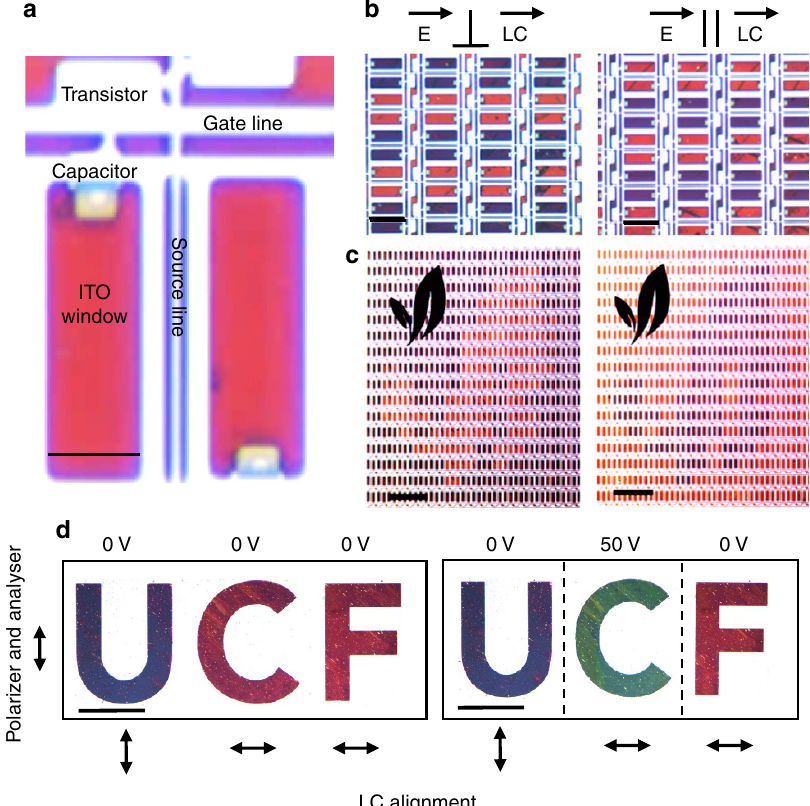
Figure 6 | Passive and active addressing. ( a ) A microscope image taken with a (cid:4) 10 objective of the plasmonic surface integrated with a thin-film- transistor (TFT) array. Pixels can be controlled through a computer interface and ( b ) shows when every third and fourth row are turned on for the parallel and perpendicular incident light cases with respect to the top LC alignment layer. ( c ) Arbitrary images displayed from the device taken with a (cid:4) 4 microscope objective. ( d ) A passively addressed device with UV lithographically patterned ‘UCF’ as a function of applied field, polarizer and analyser alignment and LC photoalignment director. Scale bars, ( a ) 30 m m, ( b ) 80 m m, ( c ) 0.72mm, ( d )